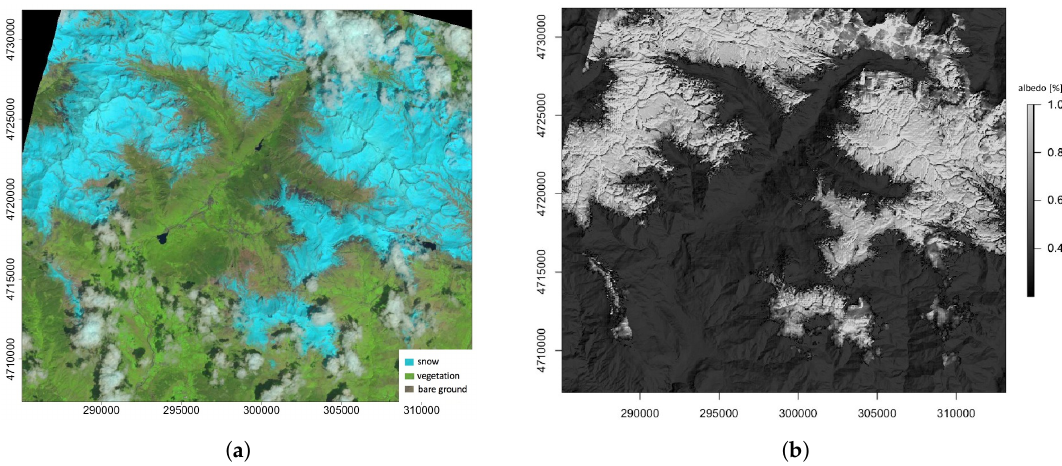
Figure 2. Initial conditions for snow cover and albedo derived from Landsat. ( a ) Landsat “natural look” image of 10 June 2013; ( b ) Derived albedo superimposed on a shaded relief of the